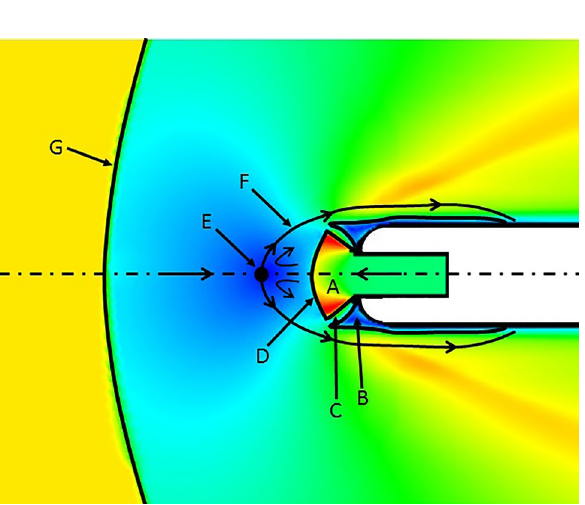
Figure 6. Mach number contours without cooling injection over the complete airfoil ( a ) and at the leading edge region ( b ) and with subsonic ( c ) and supersonic ( d ) injection at the leading edge region.